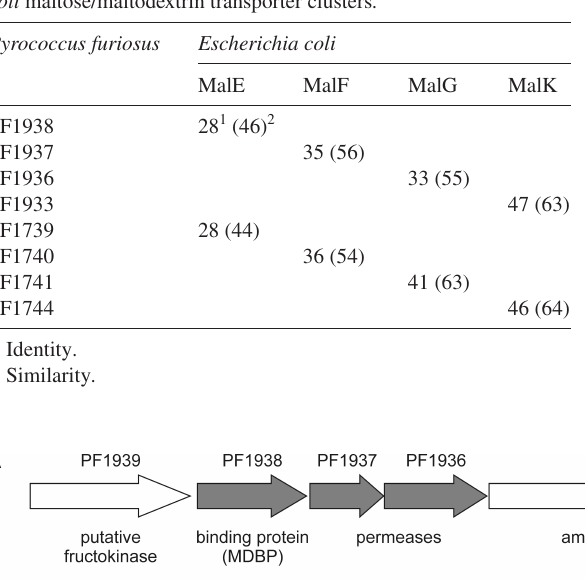
Figure 1. Organization of genes encoding the (A) malto- dextrin (indicated in grey) and (B) trehalose/maltose (indi- cated in black)